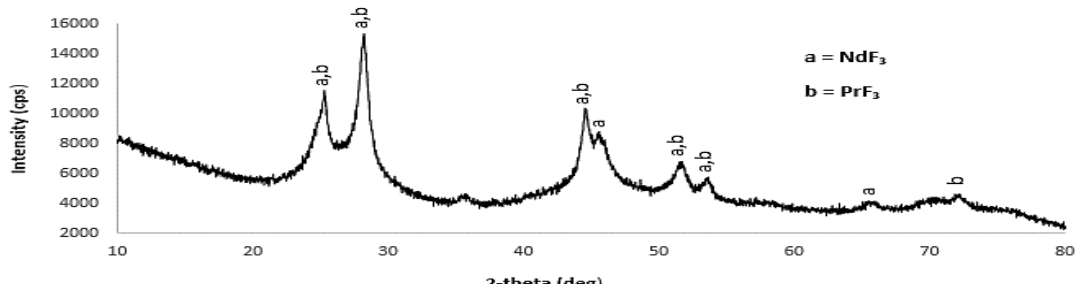
Figure 5. Crystal phases in the REF filtrate after 45 min in NH 4 F · HF and heated to 400 ◦ C.